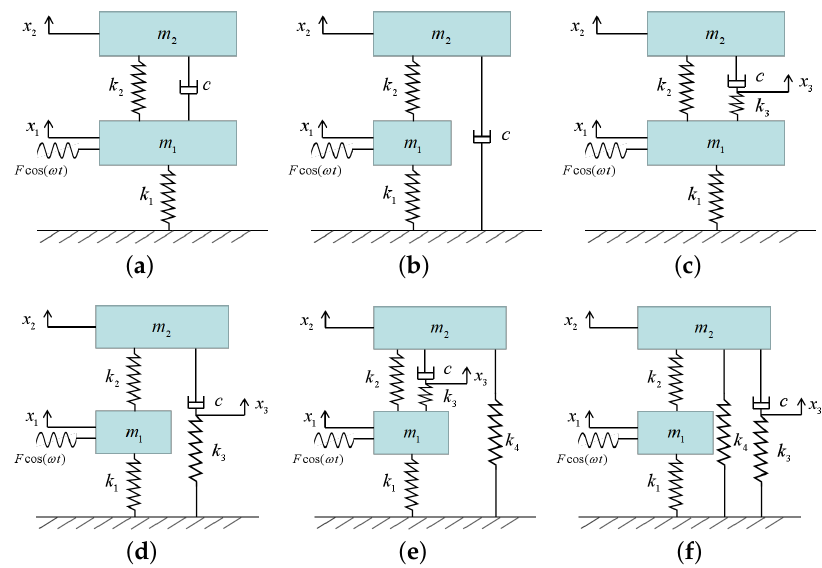
Figure 12. The DVA models: ( a ) Den; ( b ) Ren; ( c ) Asami; ( d ) Wang; ( e ) Asami with negative stiffness; ( f ) Wang with negative